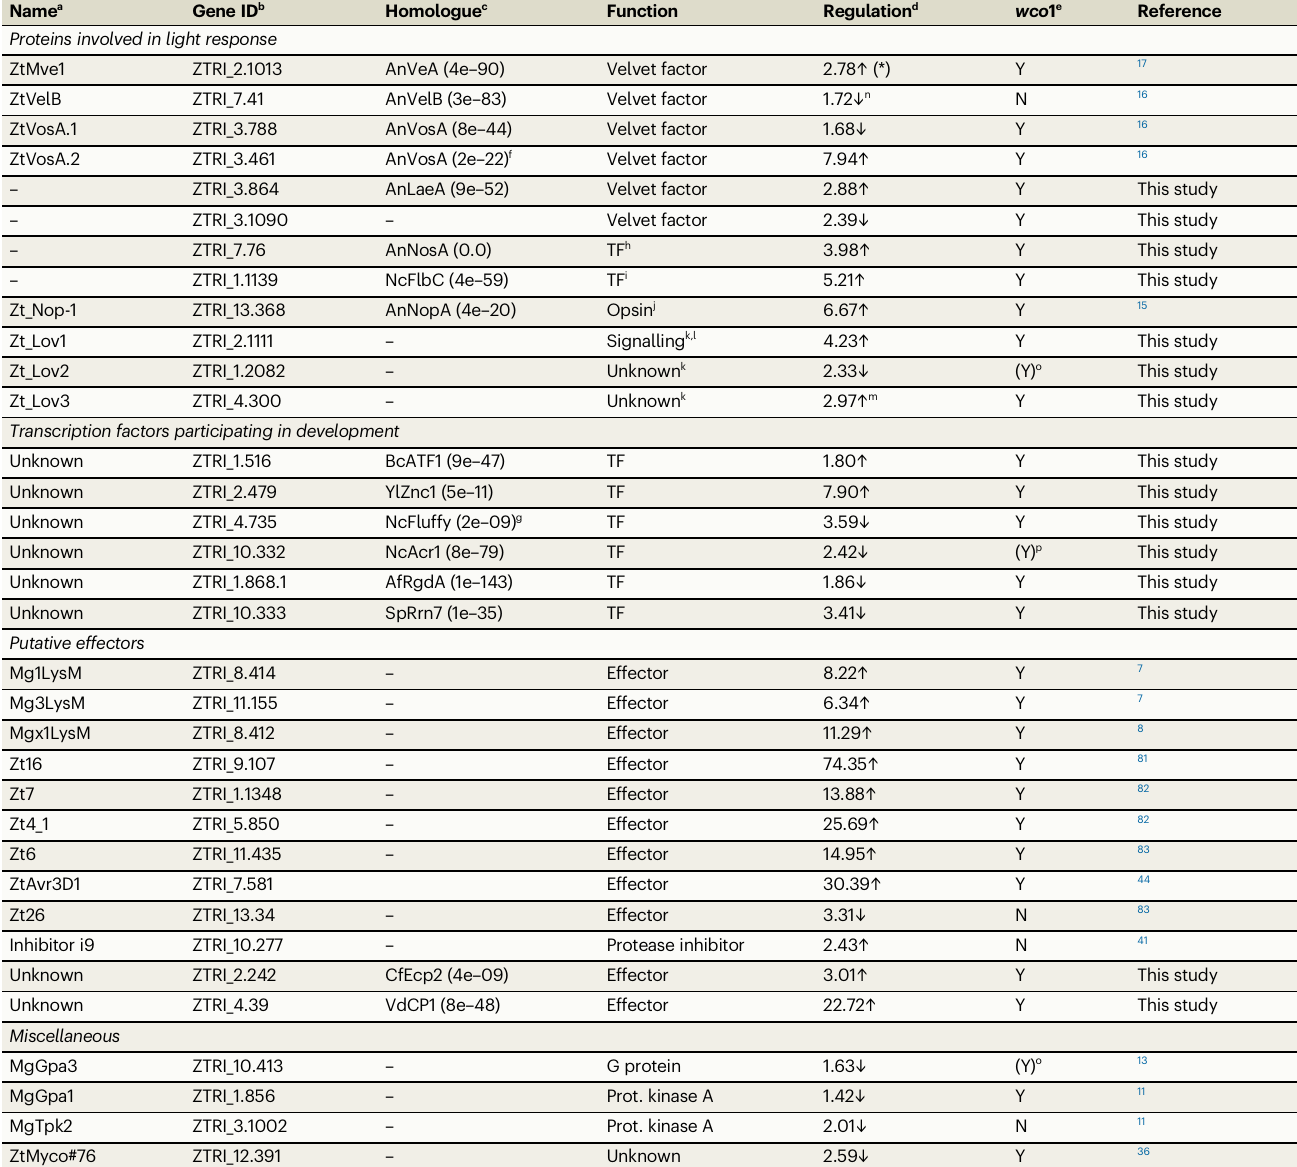
Table 1 | Fungal morphology determinants and effectors in PCDG data